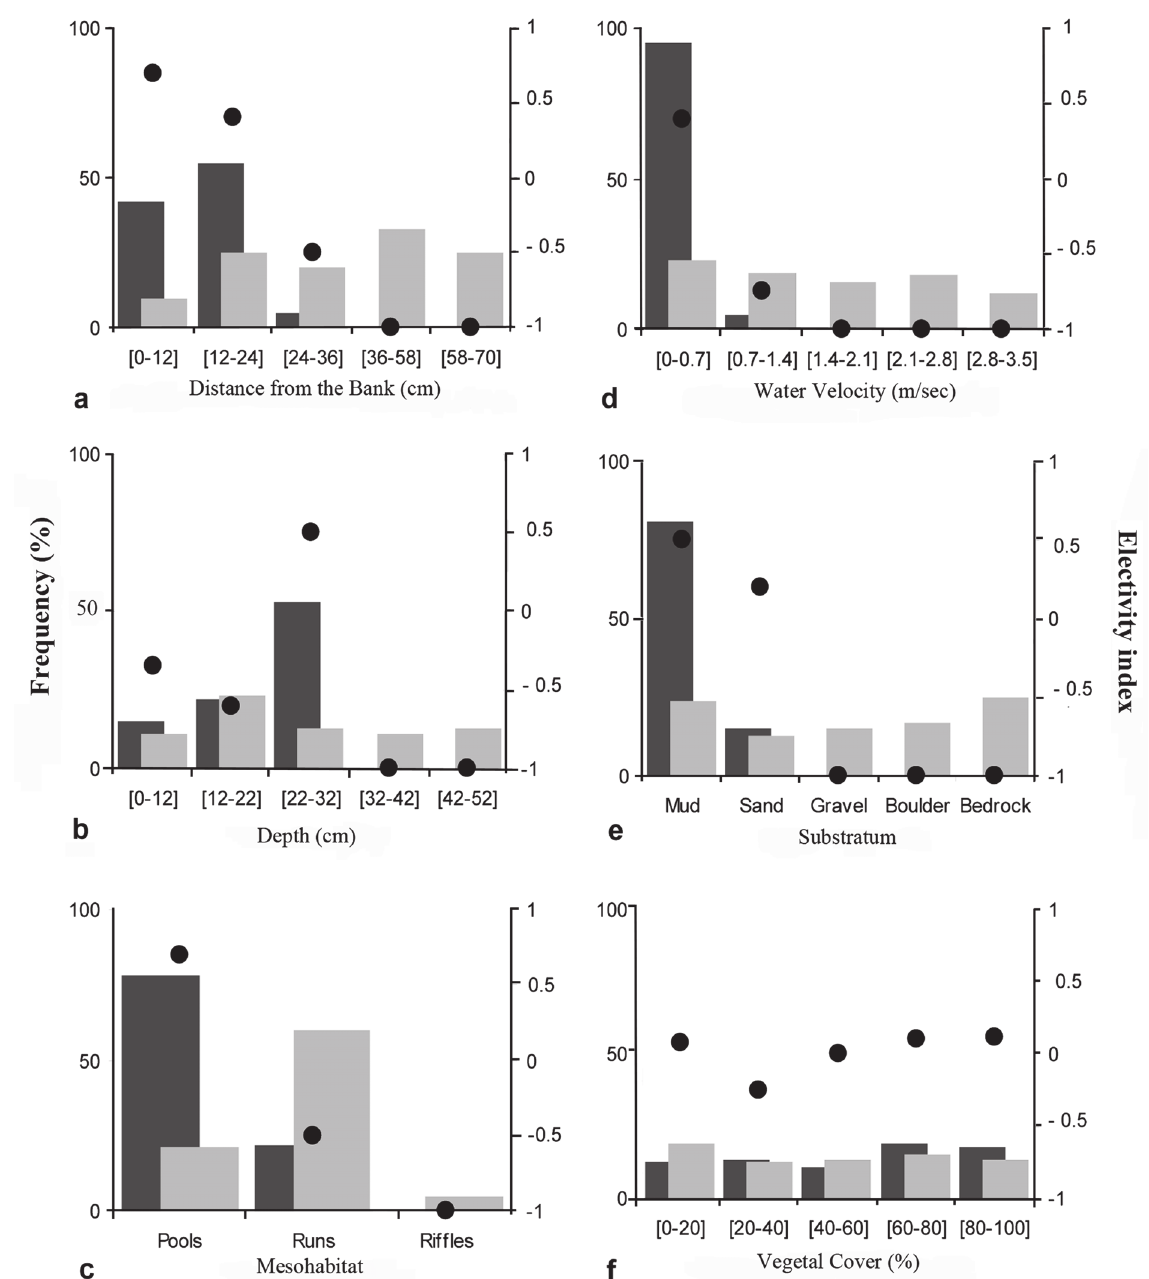
Fig. 3. Availablity (light grey bars), use (dark grey bars) and Ivlev Index (black circles) for the six studied microhabitat descriptors affecting juvenile individuals of Phalloceros harpagos populations from Mato Grosso stream: ( a ) distance from the nearest bank; ( b ) total depth; ( c ) mesohabitat; ( d ) focal water velocity; ( e ) substratum, and ( f ) vegetal cover